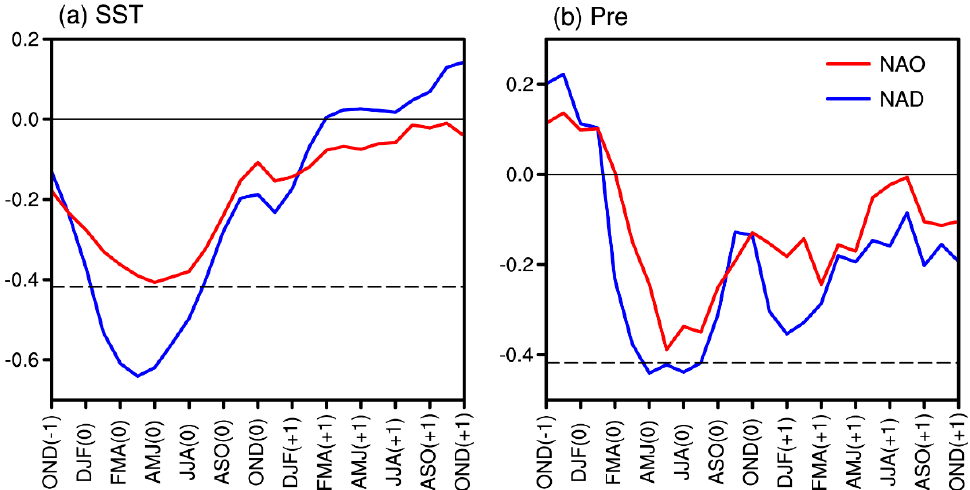
Figure 4. ( a ) Lead–lag correlations of the DJFM-averaged NADI and NAOI with the overlapping MAM-averaged values of the NTA SST (–1: year prior to the NADI; 0: year concurrent with the NADI (NAOI); +1: year after the NADI (NAOI)); ( b ) as (a), but for the NTA precipitation. The horizontal dashed line shows the 99% confidence level.